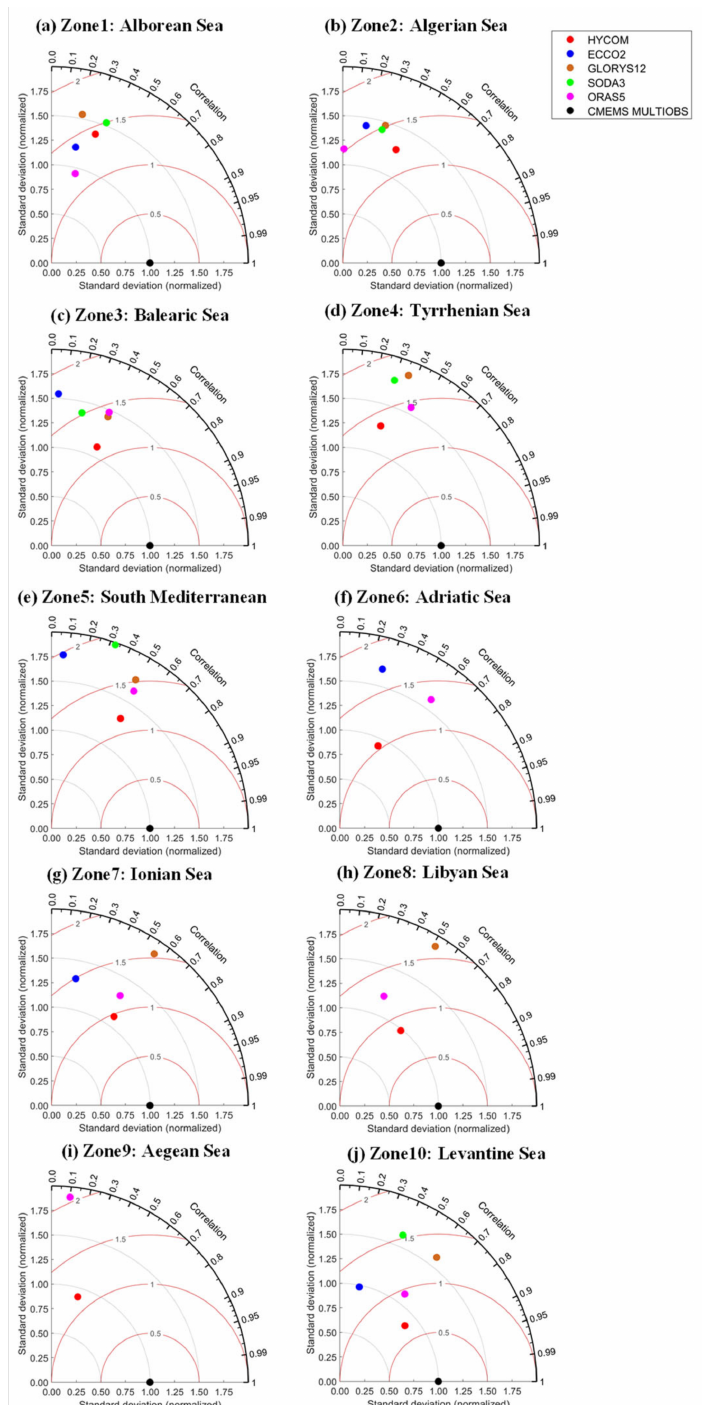
Figure 5. Taylor diagram of monthly ocean reanalysis products versus CMEMS L4 SSS for the ten zones of the Mediterranean Sea, including ( a ) the Alboran Sea, ( b ) the Algerian Sea, ( c ) the Balearic Sea, ( d ) the Tyrrhenian Sea, ( e ) the South Mediterranean, ( f ) the Adriatic Sea, ( g ) the Ionian Sea, ( h ) the Libyan Sea, ( i ) the Aegean Sea, ( j ) the Levantine Sea. The unit is in PSU for biases and RMSDs. Statistics beyond the scope (smaller than 0 for CC, larger than 2 for normalized STD and larger than 2.5 for normalized RMSD) are not marked in the